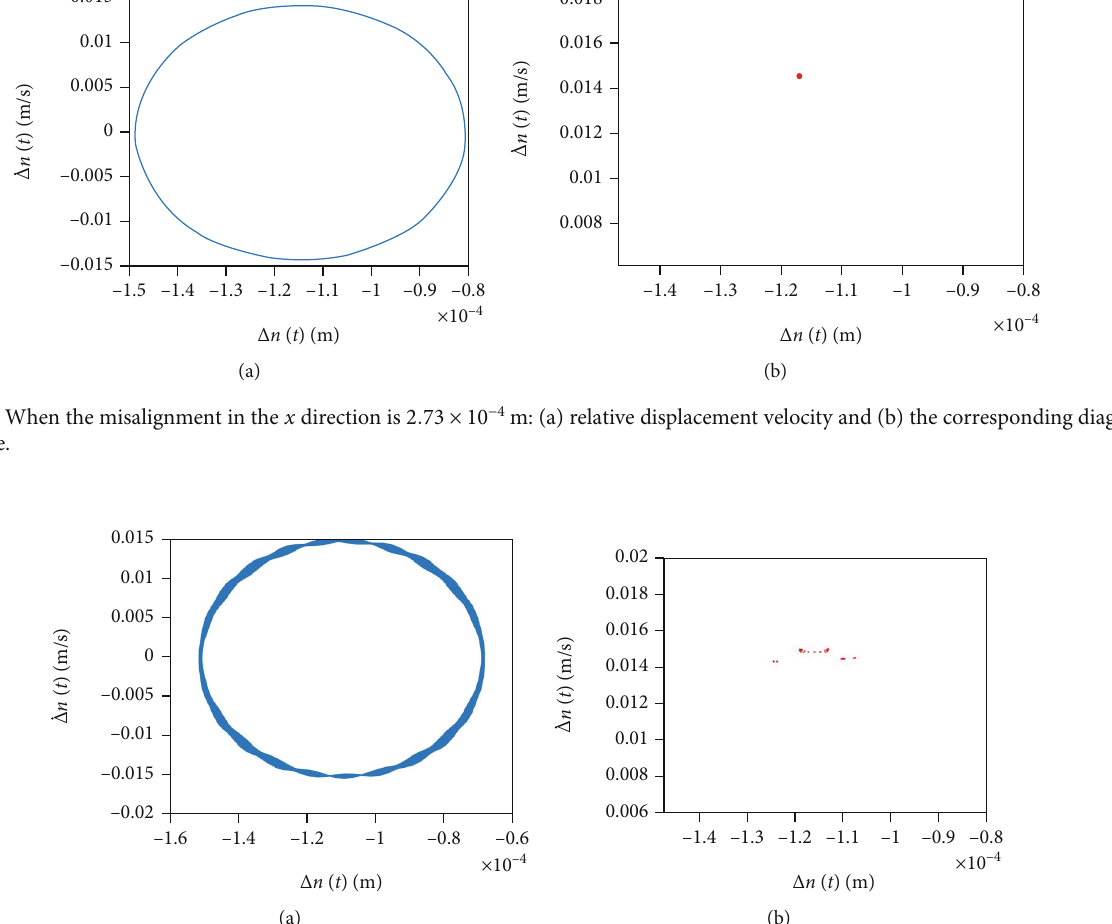
Figure 11: When the misalignment in the x direction is 2 : 83 × 10 − 4 m: (a) relative displacement velocity and (b) the corresponding diagram of Poincare.